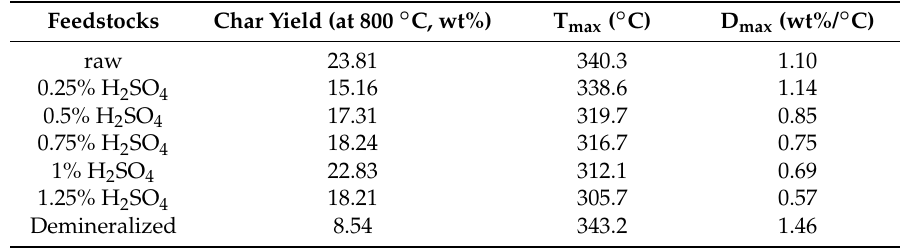
Table 2. The pyrolysis characteristic parameters of raw and H 2 SO 4 -impregnated eucalyptus. Feedstocks Char Yield (at 800 ◦ C, wt%) T max ( ◦